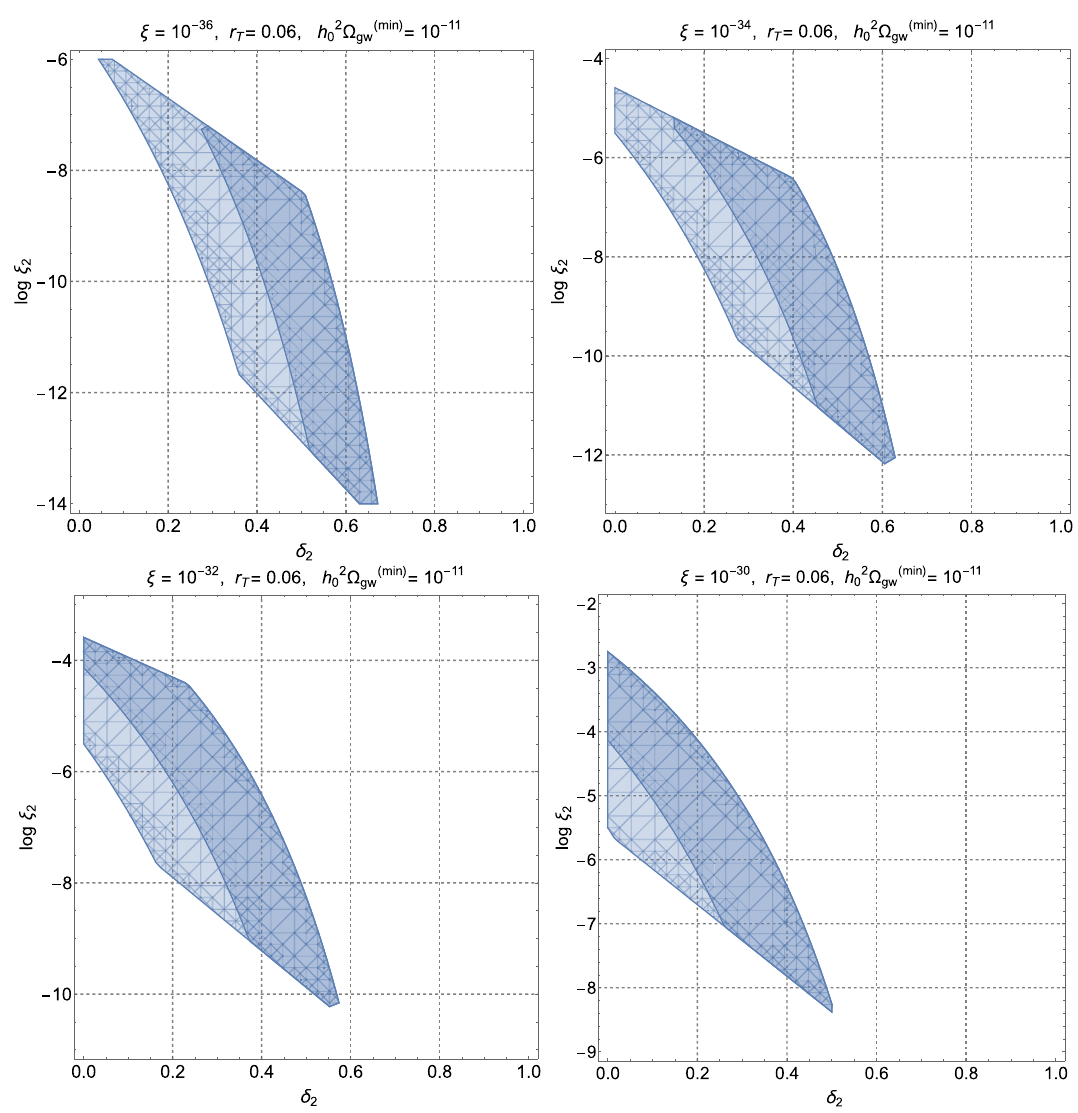
Fig. 2 The parameter space is illustrated in the plane (δ 2 , ξ 2 ) by fix- ing δ 1 to its most constraining value realized in the case δ 1 → 1. In the four different plots of this figure the value of ξ progressively increases between 10 − 38 and 10 − 30 . The shaded area corresponds to the allow